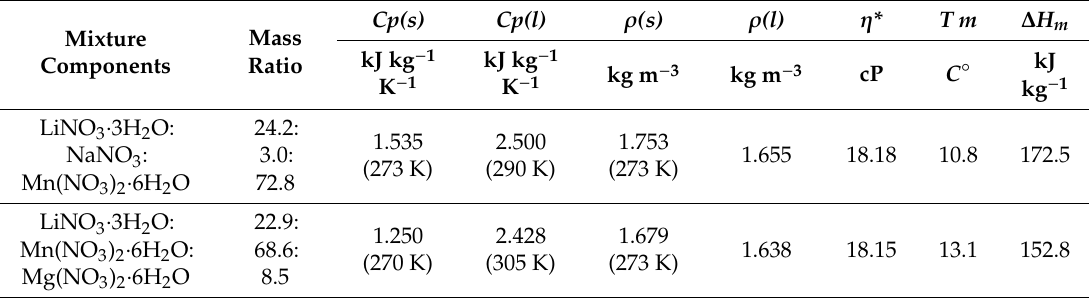
Figure 3. Calculated phase diagram of the quaternary system ( a ) LiNO 3 -NaNO 3 -Mn(NO 3 ) 2 -H 2 O, and ( b ) LiNO 3 -Mg(NO 3 ) 2 -Mn(NO 3 ) 2 -H 2 O, where ( ···· )—isotherms; (-) — univariate curve; ( ○ ) — calculated eutectic point e. (Based on [22]). Table 1. Predicted composition and experimental thermophysical characterization results of eutectic mixtures (based on [22]).